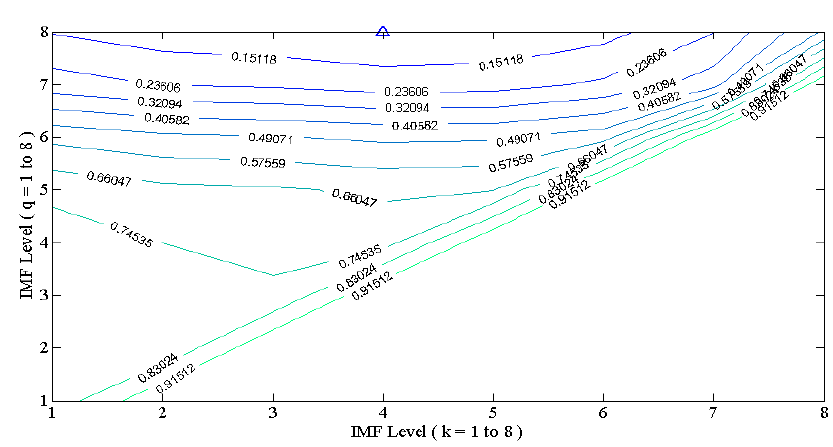
Figure 7 . Contour map of MSE under various (k,q) pairs for Ventricular arrhythmia ECG (V1) with 100% composite noise by EEMD. The (k,q) location with lowest MSE was triangle mark. In this case, k = 4 and q = 8 was the optimal